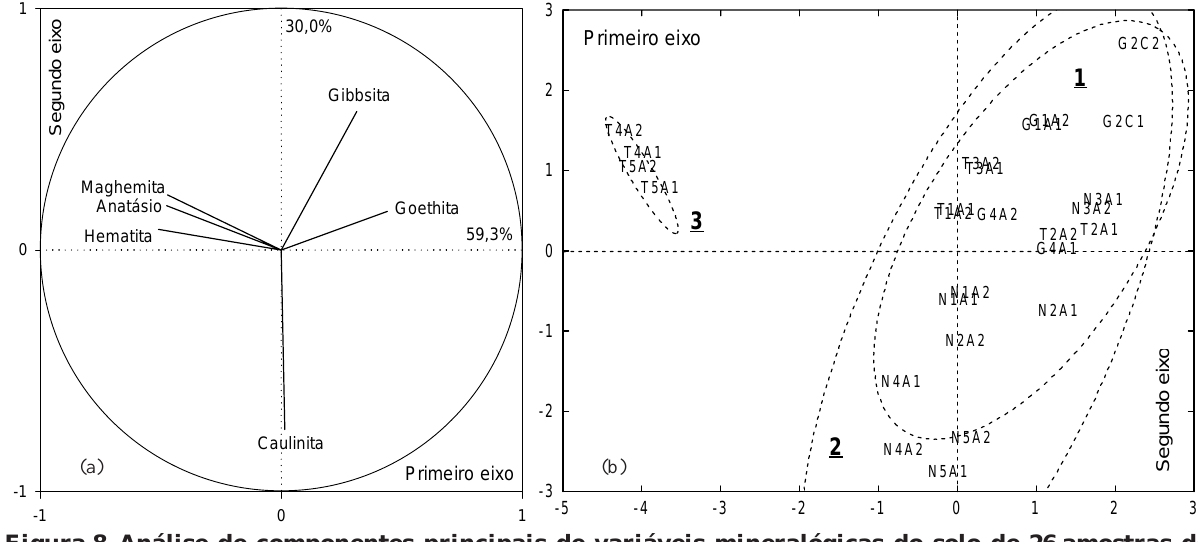
Figura 8. Análise de componentes principais de variáveis mineralógicas do solo de 26 amostras de horizontes superficiais e subsuperficiais. (a) Círculo de autovetores das variáveis; (b) Plano de elipses e dispersão de pontos dos grupos de perfis de solos. Pontos como códigos de cada perfil. Elipses: 1 = solos de textura argilosa a muito argilosa, hipo a mesoférricos; 2 = solos de textura média a arenosa, hipoférricos; 3 = solos de textura argilosa a muito argilosa, férricos.